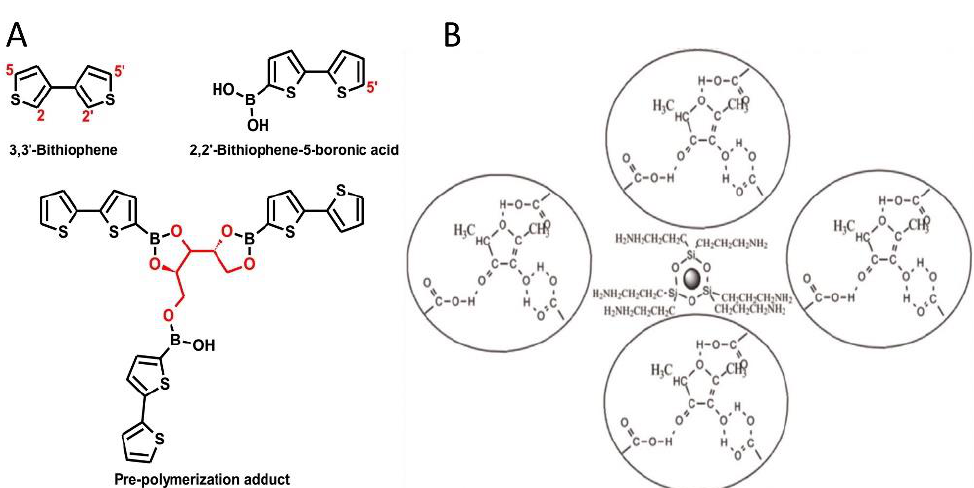
Figure 3. ( A ) Structural formulas of the D -arabitol template, 2,2′-bithiophene-5-boronic acid functional monomer, 3,3′-bithiophene crosslinker, and D -arabitol esterificated with three molecules of functional monomer. Reproduced from [18]—Published by the American Chemical Society. ( B ) Structural formulas of methacrylic acid (MAA) and 2,5-dimethyl-4-hydroxy-3(2H)-furanone (DMHF). Reproduced from [21]—Published by Elsevier B.V.